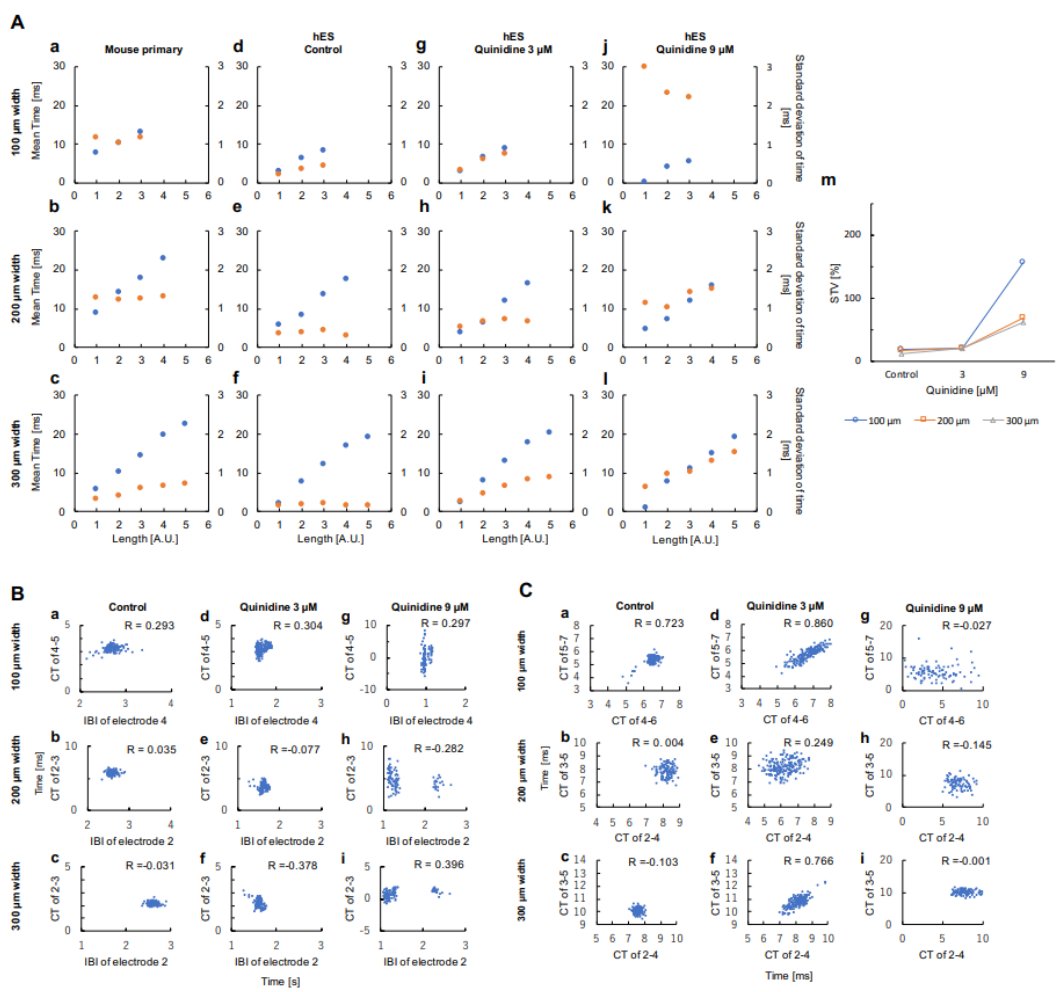
Figure 3. Characteristics of conduction time distribution in cardiomyocyte networks. ( A ) Comparison of fluctuations of conduction time in cardiomyocyte networks. (a)–(l) Unit length dependence of mean time (blue circles) and S.D. (orange circles) in 100µm width (a,d,g,j), 200µm width (b,e,h,k), and 300µm width (c,f,i,l). Mouse primary (a–c), 0µM Quinidine (Control) (d–f), 3µM Quinidine (g–i), and 9µM Quinidine (j–l). (m) The short-term variability (STV) are indicated between the neighboring electrodes from both ends of conducting section in 100µm width (blue open circles and lines), 200µm width (orange open squares and lines), and 300µm width (gray open triangles and lines) were plotted. ( B ) Correlation between inter beat interval (IBI) and conduction time (CT) in 100µm width hES network (a,d,g), 200µm width hES network (b,e,h), 300µm width hES network (c,f,i). The numbers represent